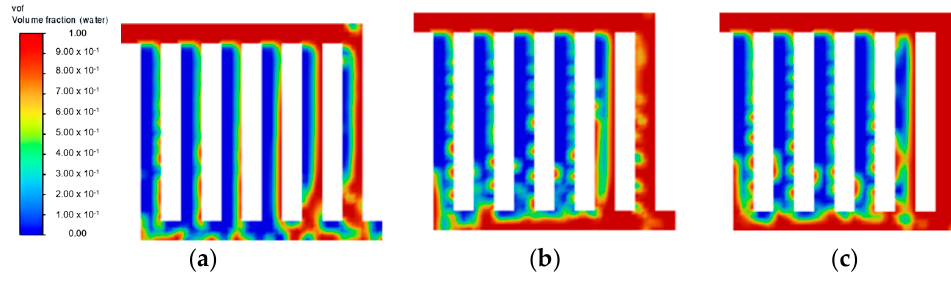
Figure 5. Parallel flow field with velocity = 0.75 m ⋅ s − 1 ( a ) 0.05 s; ( b ) 0.10 s; and ( c ) 0.15 s.